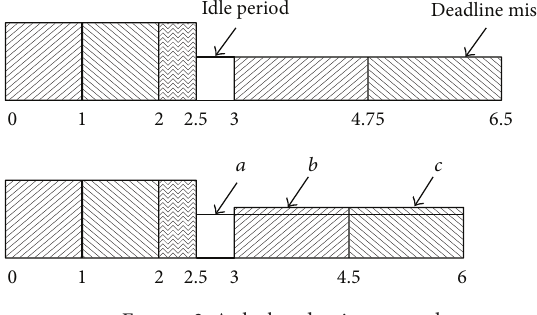
Figure 3: A slack reduction